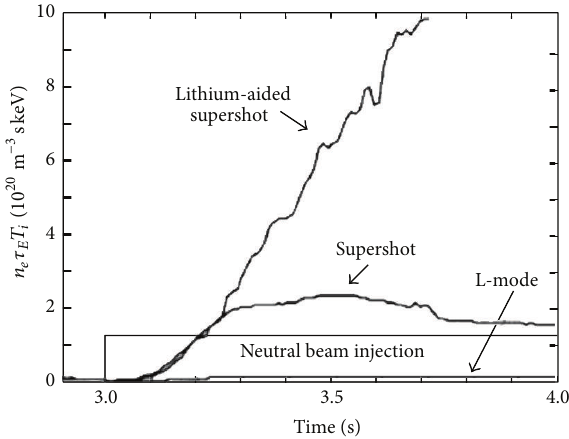
Figure 2: A 64-time increase in the fusion triple product ne 𝜏 ETi in TFTR with wall conditioning